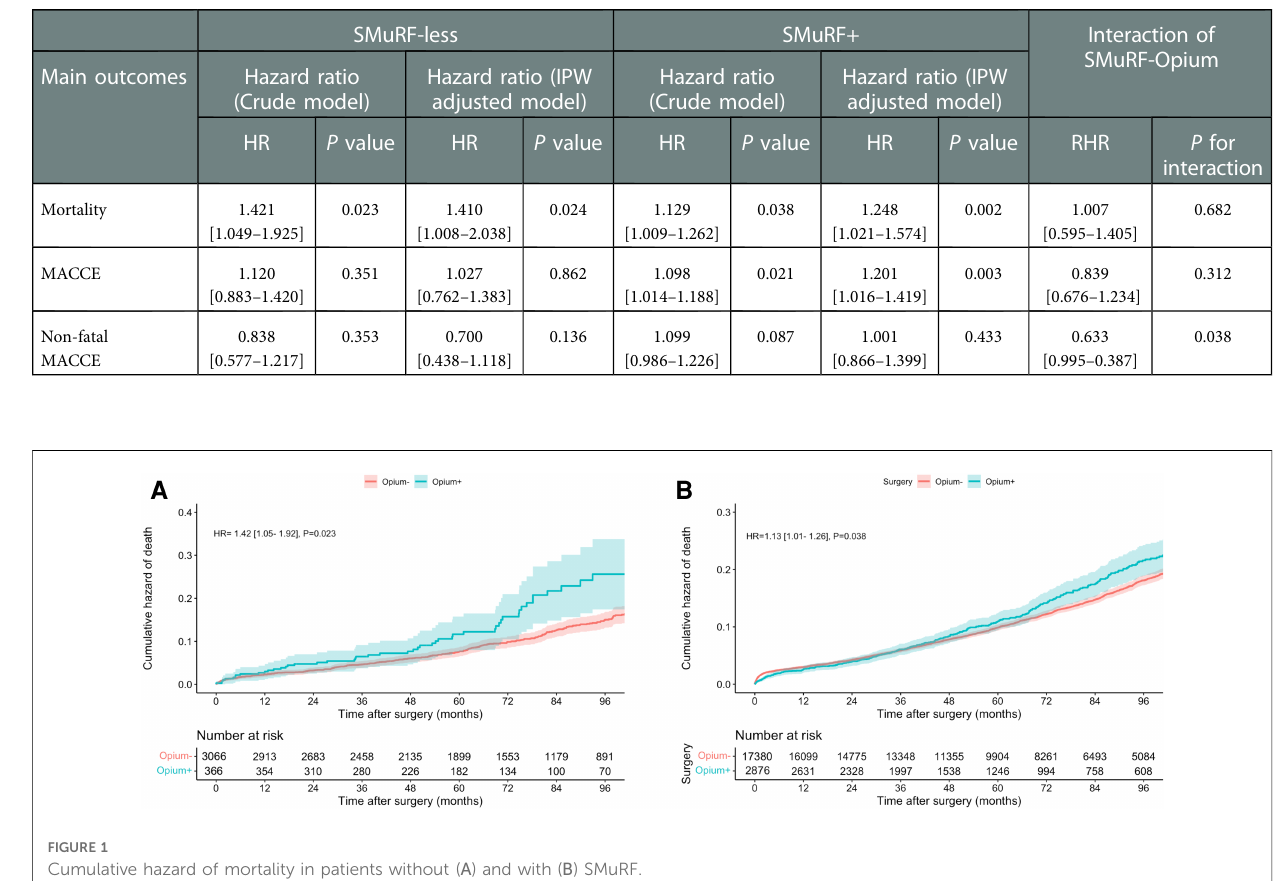
TABLE 2 Main outcomes.